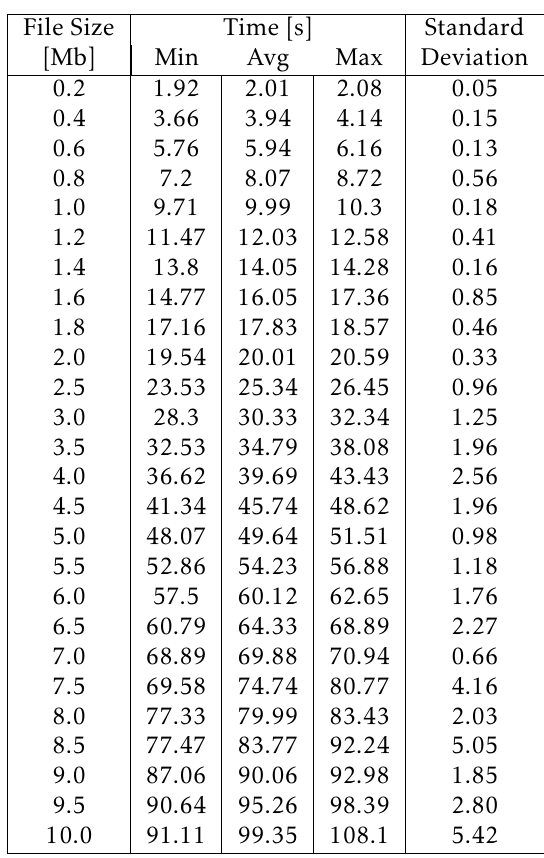
Table 3. Time required for resource encryption